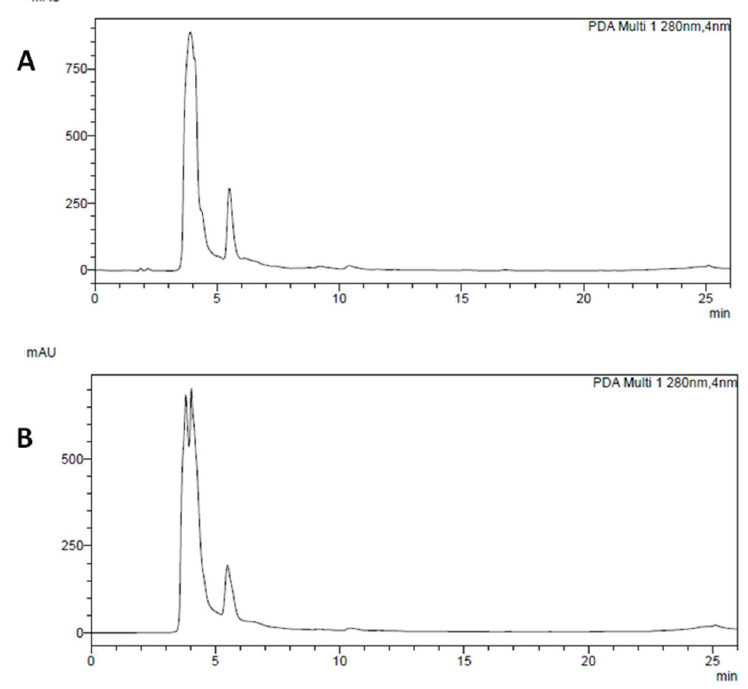
Figure 2. Chromatogram of Cannellino ( A ) and Piattellino ( B ) BF. The main compounds that could be identified in the chromatogram are hydroxycinnamic derivatives, namely those at RT = 9.2 and 10.4 min in good amounts in Cannellino, and minority compounds at RT = 15.3 and 16.8 min. 3.2. Effects of P. Vulgaris Extracts on Cell Vitality and Growth of Colon Cancer Cells To evaluate the potential antitumoral activity of SW, CW, and BF extracts of the two P. vulgaris varieties, we performed an MTT assay on HT29 and HCT116 cell lines. Colon cancer cells were treated with increasing concentrations of Cannellino and Piattellino preparations and fractions (1, 10, and 100 µ g/mL), and with the blank solution for 48 h. Results reported in Figure 3A,B indicate that soaking water (SW) and cooking water (CW) did not modify cell vitality, while the bioaccessible fraction (BF) at the concentration of 100 µ g/mL dramatically reduced cell vitality. This effect was not related to the enzymes used in the in vitro gastrointestinal digestion of beans, since the blank solution did not show activity, with a light reduction of HT29 cell vitality (16%) at the highest concentra- tion (data not shown).